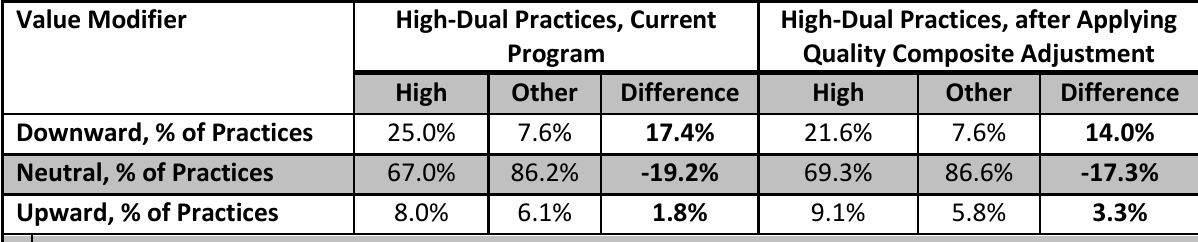
Table 10.18. Impact of Quality Composite Adjustment for High-Dual Practices Value Modifier High-Dual Practices, Current High-Dual Practices, after Applying Program Quality Composite Adjustment High Other Difference High Other Difference Downward, % of Practices 25.0% 7.6% 17.4% 21.6% 7.6% 14.0% Neutral, % of Practices 67.0% 86.2% -19.2% 69.3% 86.6% -17.3% 8.0% 6.1% 1.8% 9.1%